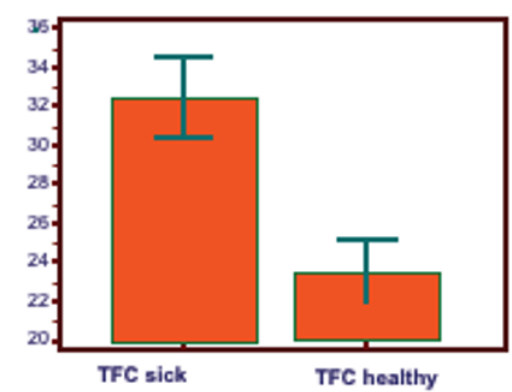
Figure 2. Comparison, in patients with positive scintigraphy, be- tween TFC in healthy vessels and TFC in diseased